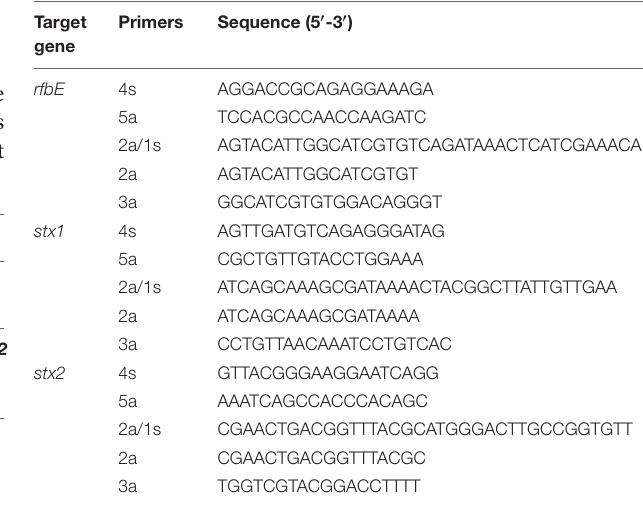
TABLE 2 | Primers sequence for